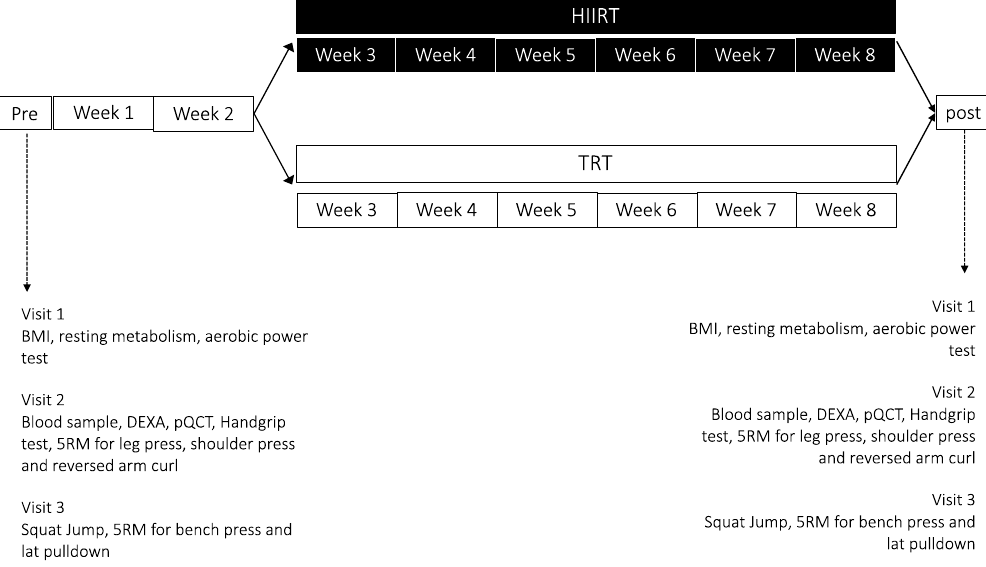
Figure 1. Study design. HIIRT, High Intensity Interval Training; TRT, Traditional Resistance Training; DEXA, Dual-Energy X-Ray Absorptiometry; pQCT, Peripheral Quantitative Computed Tomography; RM, Repetition